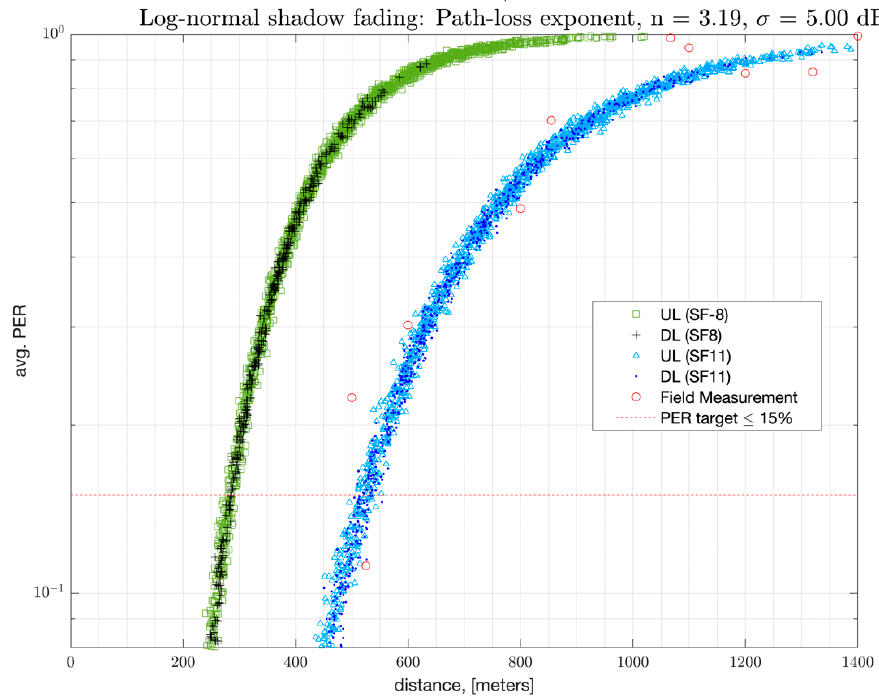
Figure 10. PER versus distance to the GW in suburban terrain (1 GW, 1 EN, and 44 bytes payload) .